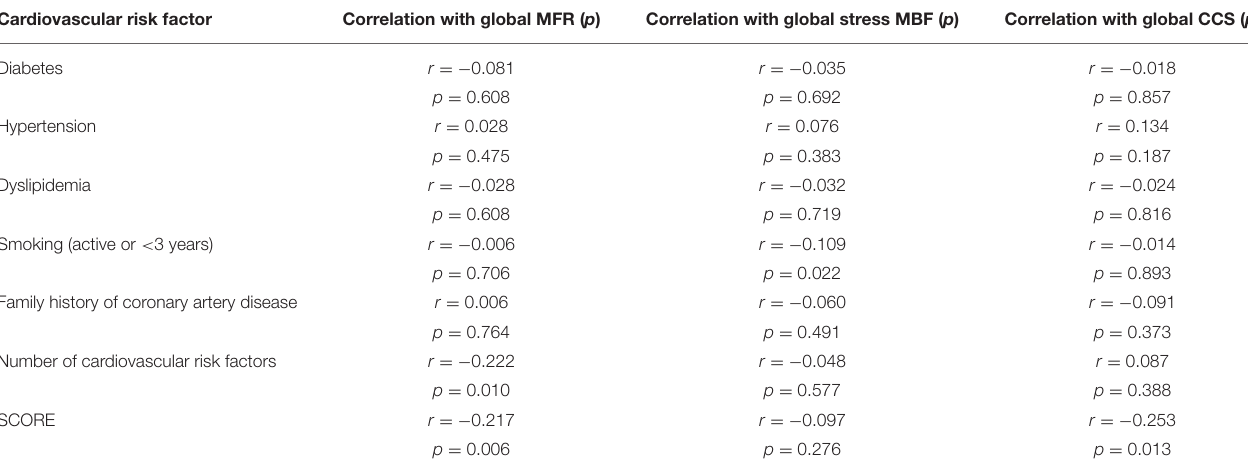
TABLE 3 | Correlation between cardiovascular risk factors, MFR, stress MBF, and CCS. Cardiovascular risk factor Correlation with global MFR ( p ) Correlation with global stress MBF ( p ) Correlation with global CCS ( p )